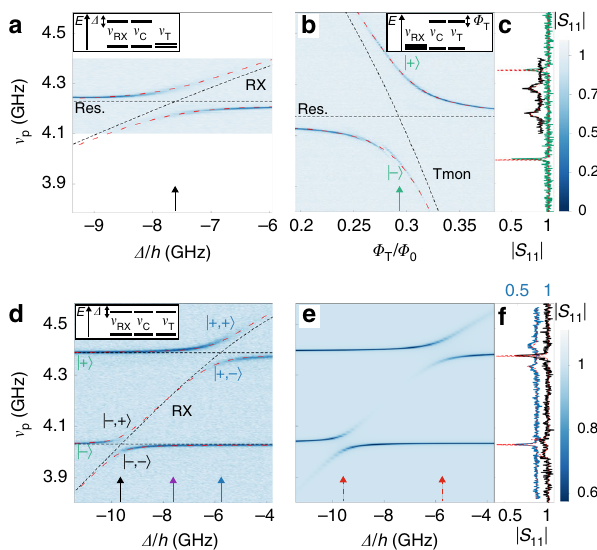
Fig. 2 Resonant interaction. The schematics at the top of the graphs indicate the energy levels of the RX qubit ( ν ), coupling resonator ( ν ) RX C and transmon ( ν ). Theory curves in the absence (presence) of coupling T are shown as dashed black (red) lines. a Re fl ected amplitude j S 11 j as a function of RX detuning Δ and probe frequency ν for RX qubit tunnel p coupling con fi guration 2. b Re fl ected amplitude j S 11 j as a function of relative = Φ ν transmon (Tmon) fl ux Φ . The states ± j i are discussed in the 0 and T p main text. c Cuts from panel a at Δ = h ’ (cid:3) 7 : 6 GHz (black) and from panel = Φ ’ 0 : 3 (green) as marked with arrows in the respective panels. b at Φ 0 T The black trace is offset in j S 11 j by 0.1. Theory fi ts are shown as red dashed lines. d j S 11 j as a function of Δ and ν for RX qubit tunnel coupling p con fi guration 2. The states (cid:3) ; ± j i and þ ; ± j i are explained in the main text. The black and blue arrows are referred to in f , the purple arrow is discussed in the text. e Result of master equation simulation for parameters j are scaled to the experimental data range in as in d . The values for j S 11 Þj at Δ = h ’ (cid:3) 9 : 8 GHz and Δ = h ’ (cid:3) 5 : 6 GHz as marked with the d . f j S 11 ð ν p corresponding colored arrows in panels d , e . The blue trace is offset in j S j by 11 Fig. 2d, avoided crossings are visible at both resonance points. This indicates the coherent interaction of the three quantum systems which form the states (cid:3) ; ± j i and þ ; ± j i , where the second label indicates a symmetric or antisymmetric super- position of the RX qubit state with the transmon-resonator ± j i states. The splitting 2 g (cid:4) between (cid:3) ; ± j i and þ ; ± j i is extracted